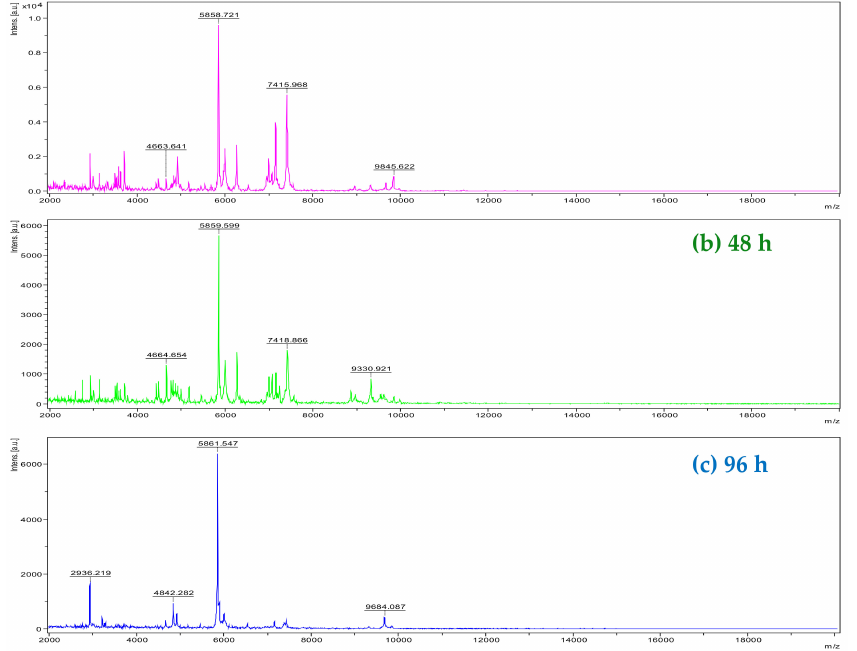
Figure 2. Profile of Xcc macromolecules by MALDI-TOF MS at 24 ( a ), 48 ( b ), and 96 h ( c ) after plating onto NBY agar medium. y -axis: ion intensity. x -axis: mass/charge ( m/z ).